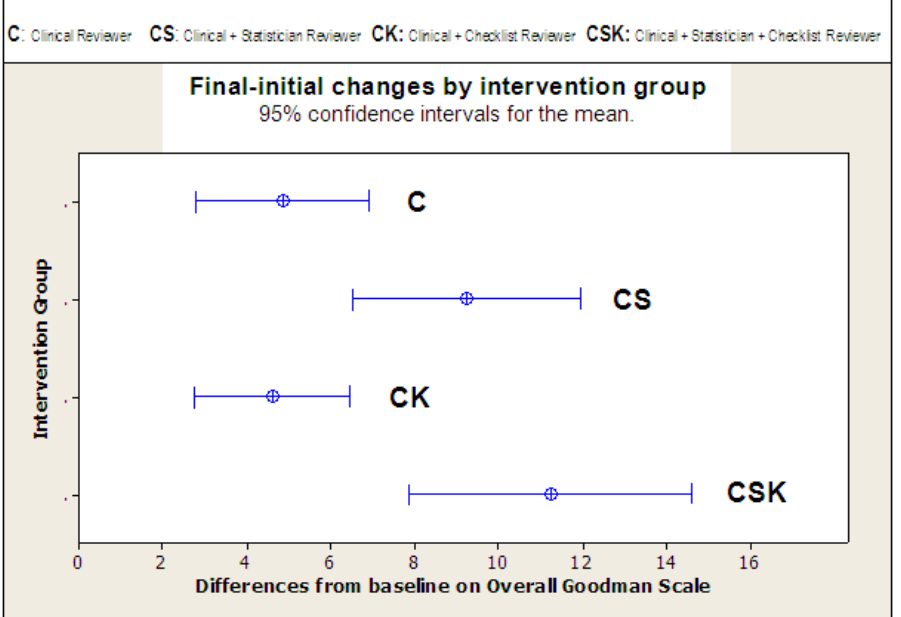
Figure 2. Mean quality changes, with uncertainty confidence intervals, from initial version to final version of the full Goodman scale. The overall quality is computed by the addition of the scores obtained in each one of the 36 items of the scale (first item is a summarizing measure of quality and thus, not included). The two groups without a statistical reviewer had a final-initial difference of 4.5 and 4.7 points, equivalent to a final-initial change in one item from very poor to excellent. Indeed, the two groups with a methodological referee changed 9.1 and 11.3, more than a complete reversal in the evaluation of two items. Thus, the effect size of adding a statistical reviewer is computed as the weighted average of the changes in groups CS + CSK minus changes in C + CK.